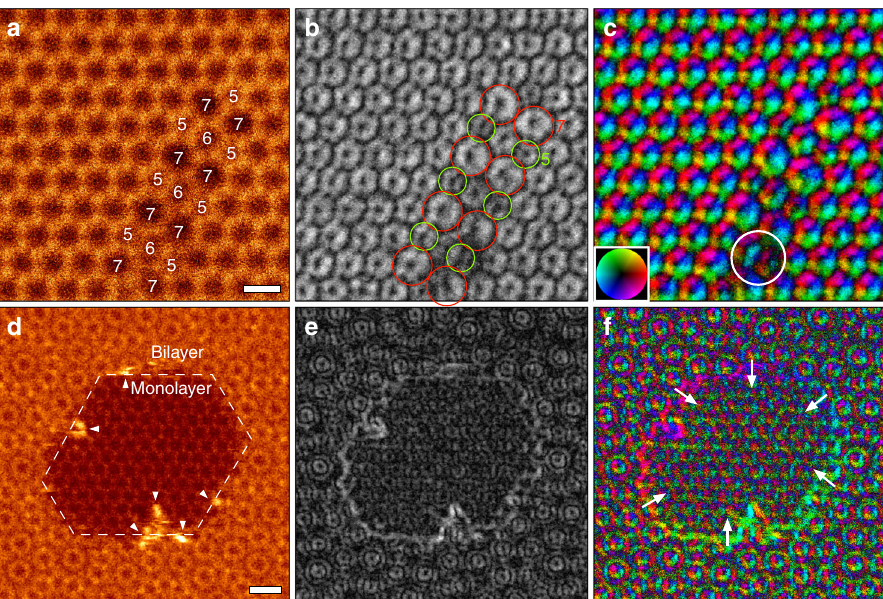
Fig. 3 Atomic-resolution ADF and electric fi eld maps at defects in graphene. a , d ADF-STEM images (512 × 512, 40 μ s/pixel), b , e electric fi eld strength maps, c , f electric fi eld vector maps obtained from Stone – Wales defect and nanopore regions, respectively. The contrast ranges are ( b ) 0 – 25 V, ( e ) 0 – 45 V. The white arrows in ( f ) indicate the direction of the electric fi eld. The scale bars in ( a ), ( d ) are 3 Å and 5 Å,